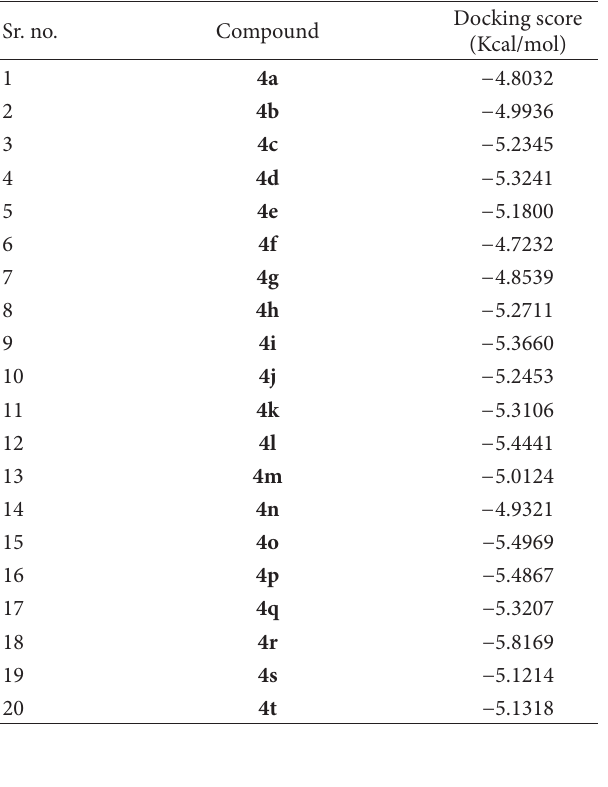
T 6: Grid docking score of title compounds. Sr. no.